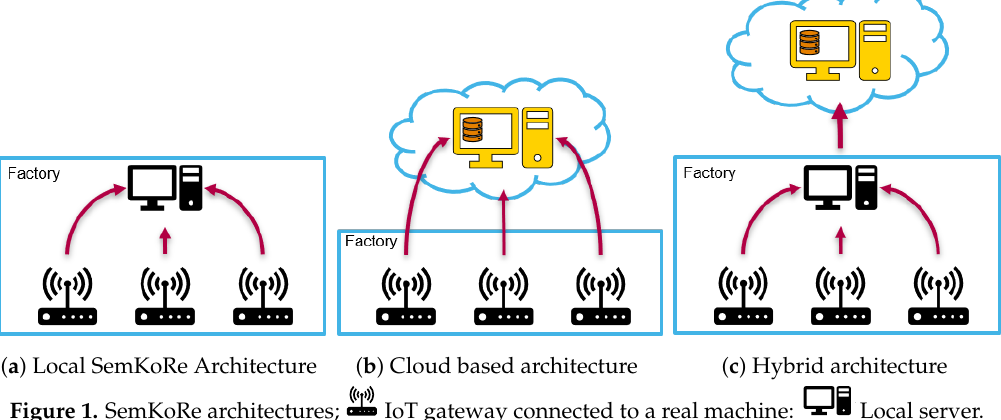
Figure 1. SemKoRe Architectures; IoT gateway connected to a real machine: Local server